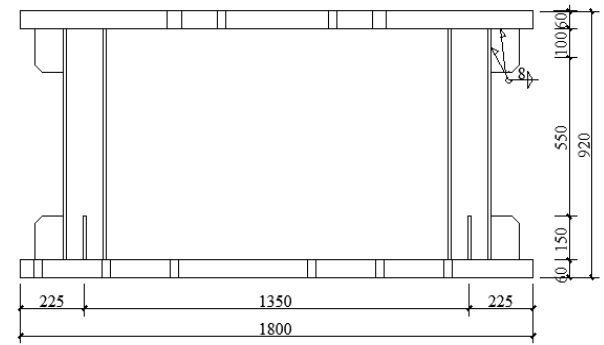
Figure 23. Elevation of specimen 2 (units: mm).